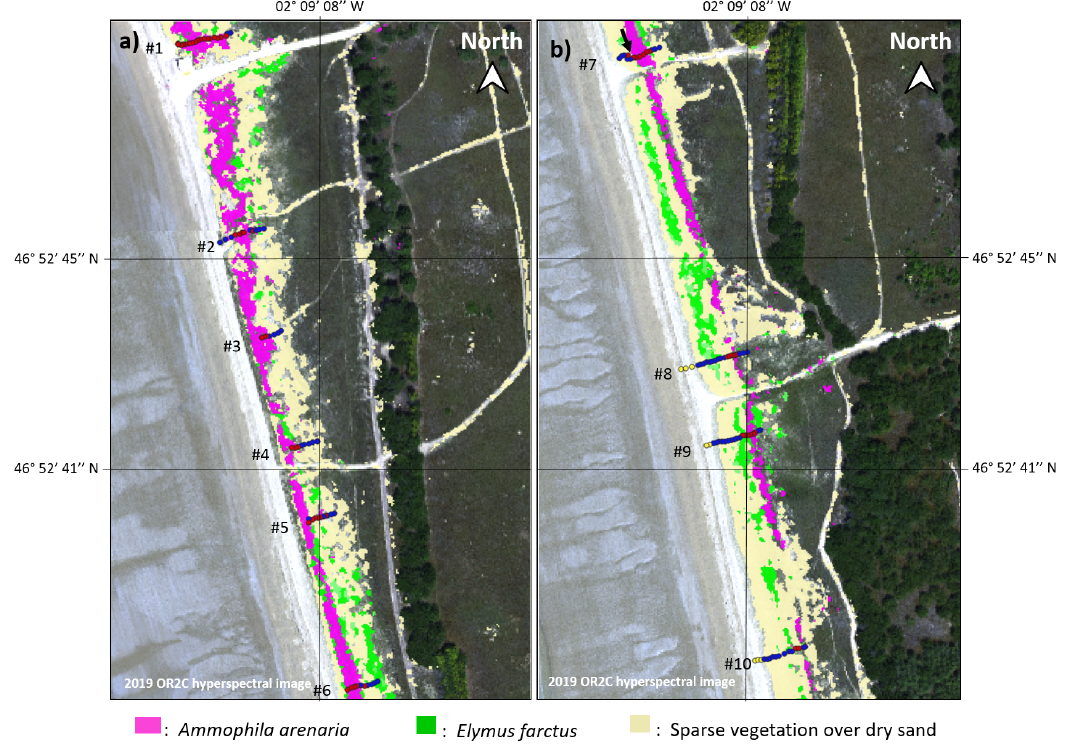
Figure 14. Pays-de-Monts validation area (b in Figure 2) of true color hyperspectral display with maps of Ammophila arenaria ( magenta ), Elymus farctus ( green ), and sparse vegetation over dry sand ( light yellow ). Locations of dGPS foot points of Ammophila arenaria are shown in red, Elymus farctus in addition to those classified as sparse vegetation over dry sand are shown in blue, and the yellow ones are beach-top samples; ( a ) displays the 6 first profiles (b1 Figure 2) cutting Ammophila arenaria polygons larger than 3 pixels; ( b ) displays the last 4 profiles (b2 Figure 2) cutting narrower Ammophila arenaria